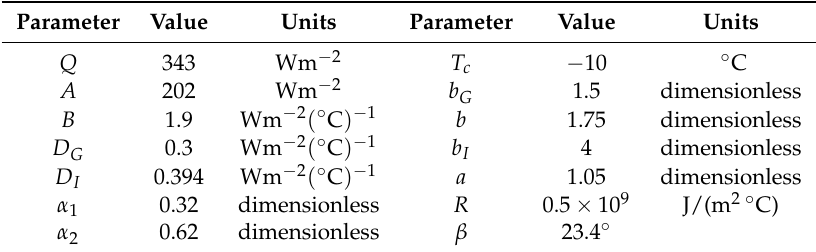
Table 1. Parameter